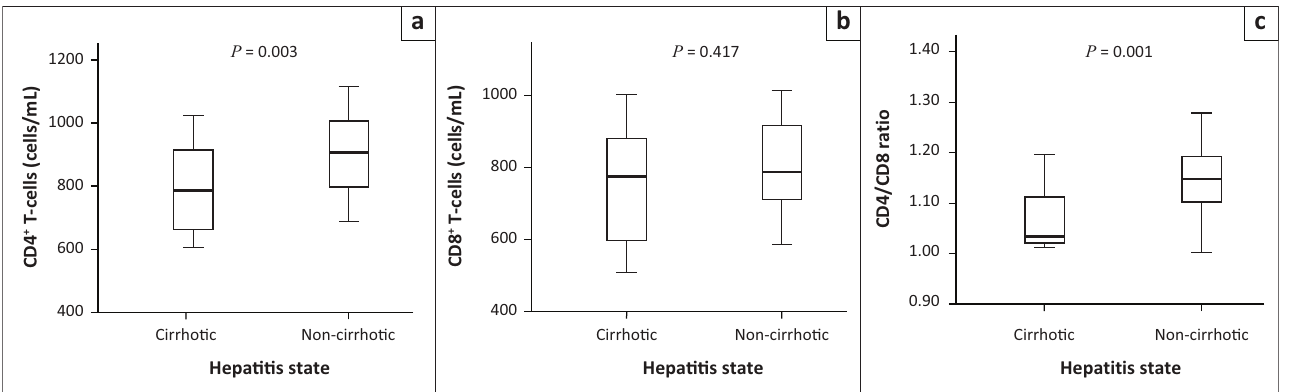
FIGURE 2: Value of CD4 + T-cells, CD8 + T-cells and the CD4/CD8 ratio in cirrhotic and non-cirrhotic hepatitis B virus-positive patients at Yaoundé General Hospital, Cameroon, September–December 2018. TABLE 2: Correlation between CD95, CD95L, fibrosis score, CD4 + T-cells, CD8 + T-cells and CD4/CD8 ratio of hepatitis B virus-positive patients at Yaoundé General Hospital, Cameroon, September–December 2018. Lymphocytic and hepatic parameters